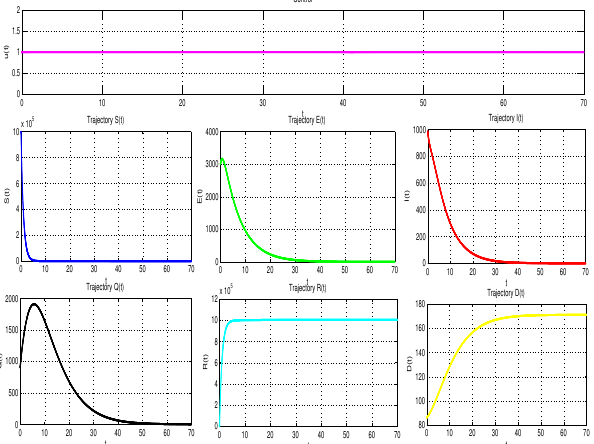
Figure 7. Evolution of stats with vaccine, after 70 days.